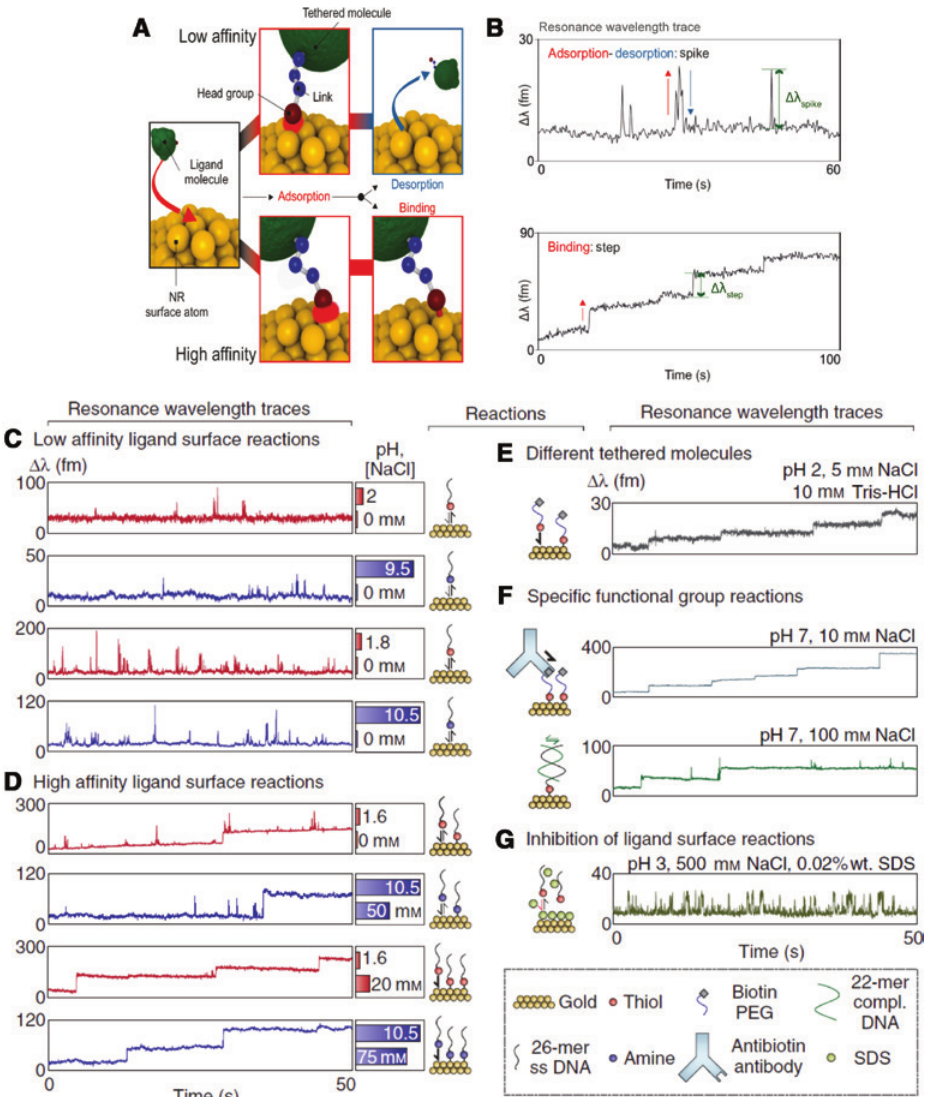
Figure 13: Probing single-molecule surface reactions with optoplasmonic sensors. (A) Surface reactions with low and high affinity. (B) The corresponding single-molecule WGM sensor signals. Spikes indicate low-affinity reactions, while steps indicate high-affinity reactions. (C–G) Overview of reactions monitored with a hybrid photonic-plasmonic single- molecule sensor. Adapted from